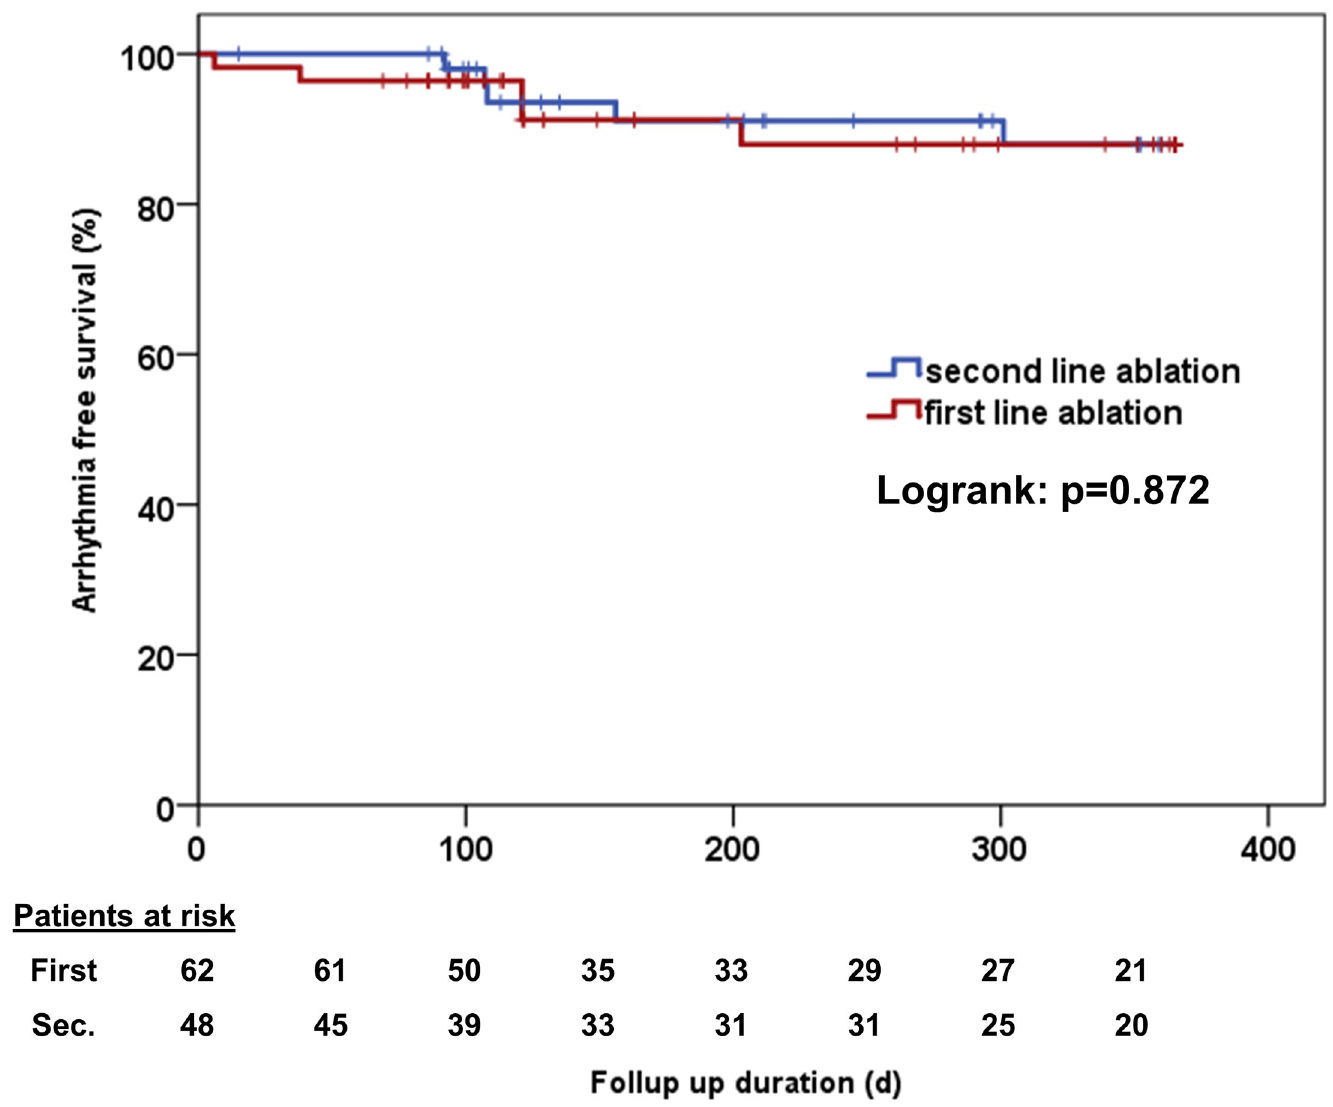
Fig 2. Multiple procedure success rate on and off antiarrhythmic drugs. There was no significant difference between patients who received ablation as a first or second line therapy (Log rank test: 0.872).